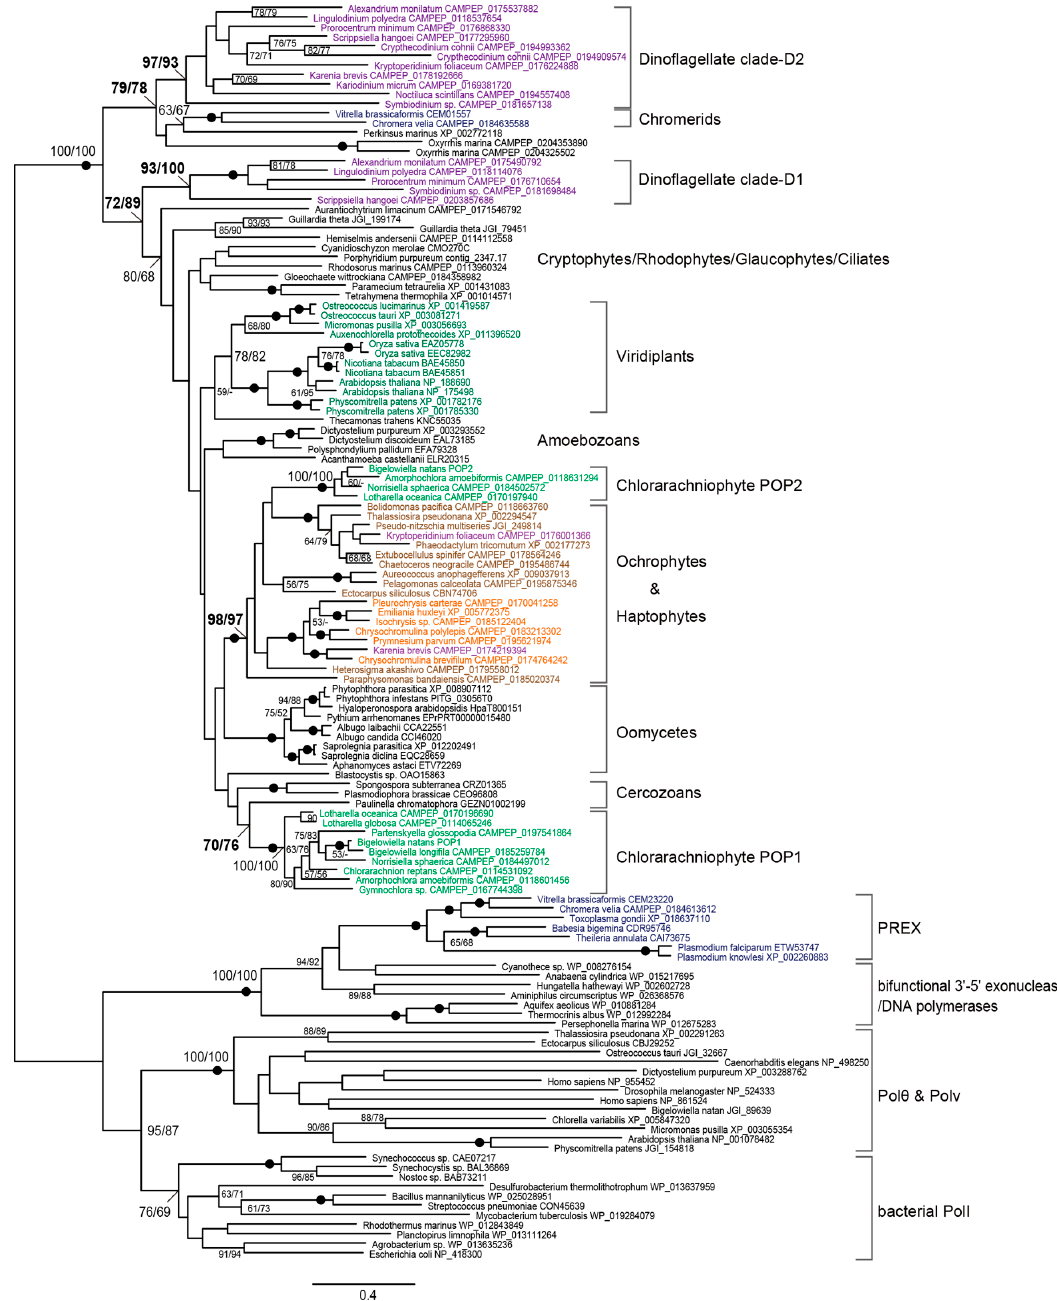
Figure 1. Maximum likelihood phylogenetic tree of family A DNA polymerases, including 93 POPs (plant and protist organellar DNA polymerases). The tree was generated under the LG+R7 model implemented in IQ-TREE. The values at nodes indicate bootstrap supports calculated by the two different substitution models (LG+R7/LG+C20+F+ Γ ) when they are higher than 50%, and black dots on branches represent robust supports (>95%). The scale bars show the number of inferred amino acid substitutions per site. Accession numbers of GenBank, JGI (Joint Genome Institute)/, and MMETSP (Marine Microbial Eukaryotic Transcriptome Sequencing Project) are shown on the right side of species names.